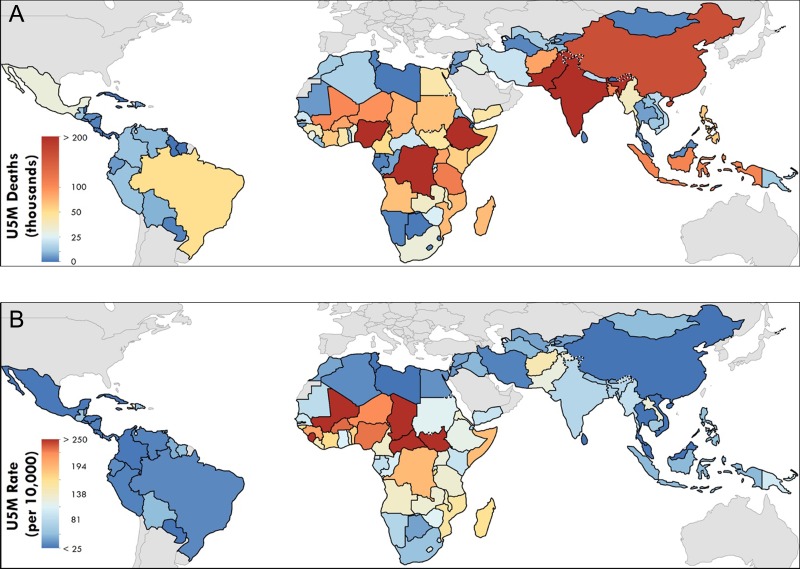
National-level estimates of under-5 mortality (U5M) in 103 LMICs in 2017. (A) Total number of deaths in children <5 y of age in 2017. (B) Probability of death for children <5 y of age in 2017.